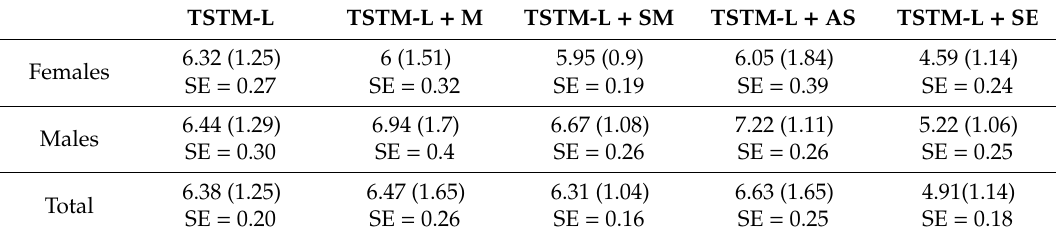
Table 3. Descriptive statistics: means (standard deviations) and standard errors (SE).